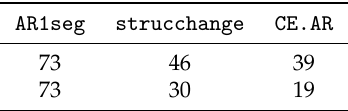
Table 7. Hausdorff distance for each algorithm and two choices of the